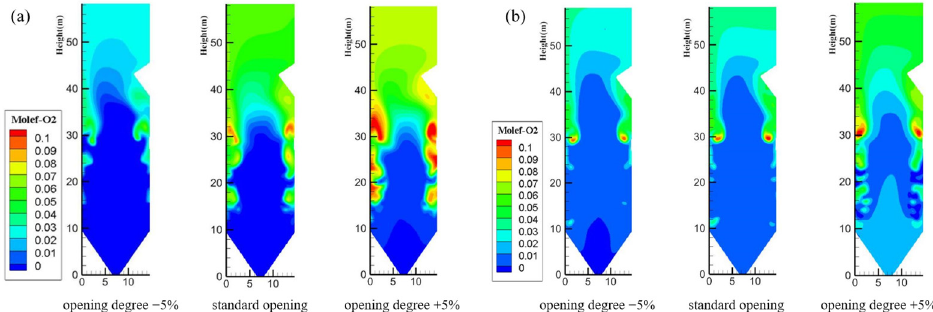
Figure 8. The oxygen molar concentration distribution with variable combustion air opening. ( a ) 180 MW. ( b ) 320 MW.